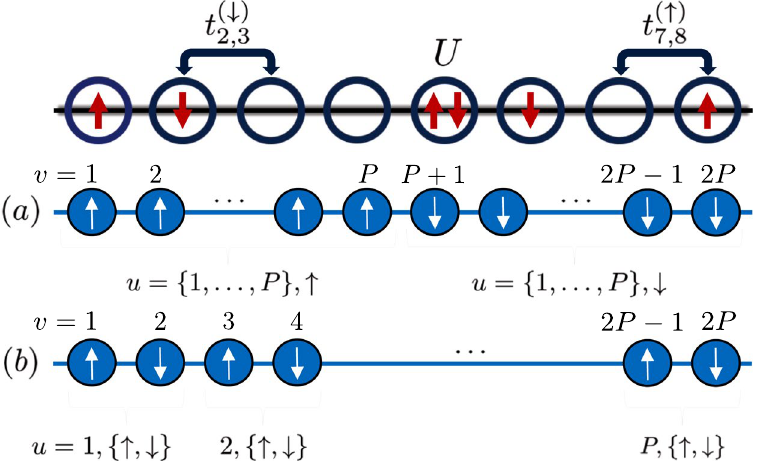
Figure 2. Index ordering options for the 1D Hubbard